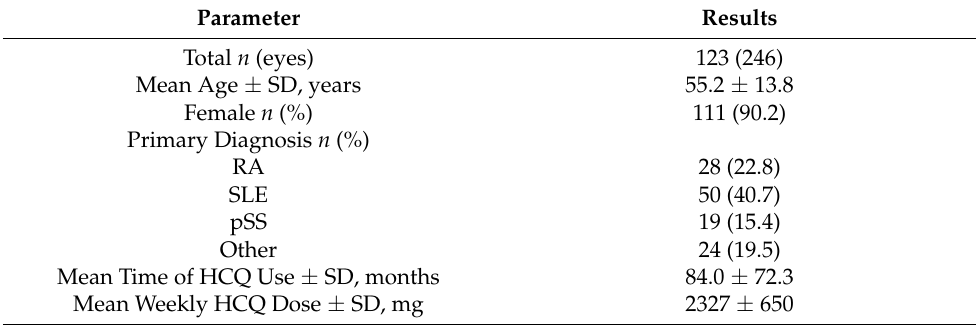
Table 1. Demographic and clinical characteristics of included